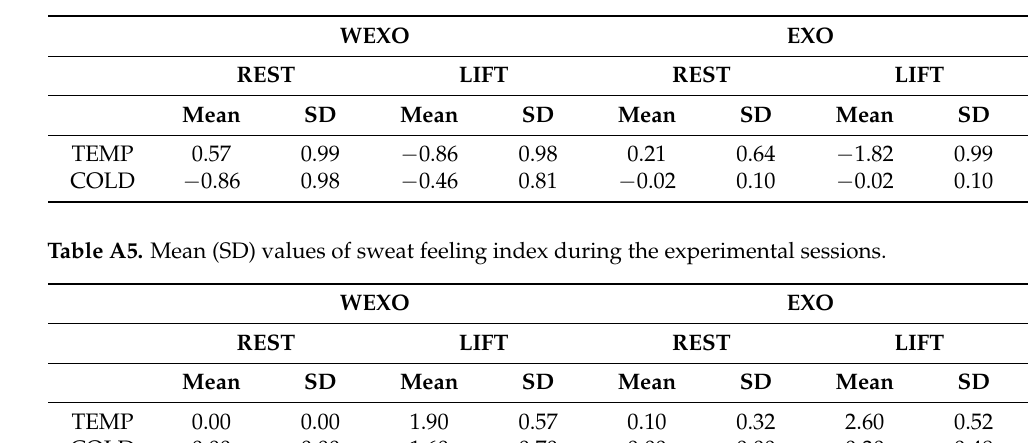
Table A4. Mean (SD) values of thermal comfort vote during the experimental sessions.